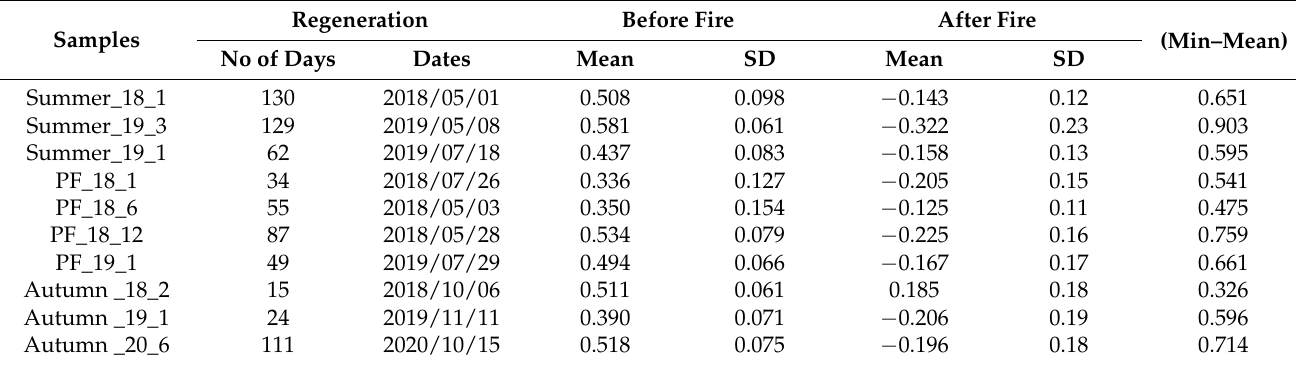
Table 4. Data for each polygon used in NBR analyzes.